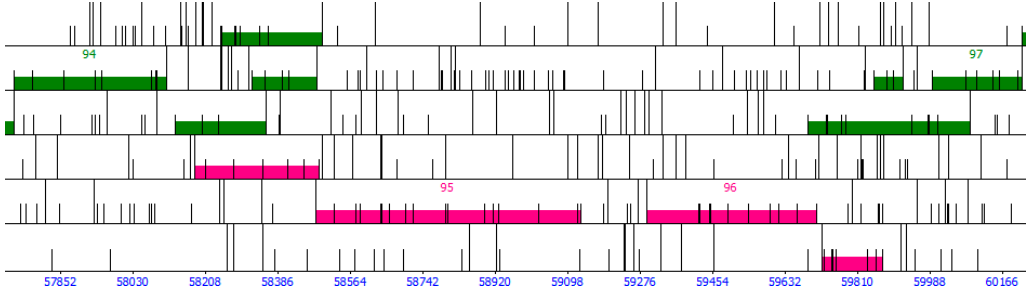
Figure 4. Examples of program-identified genes and user-identified putative genes in DNA Master. Each row corresponds to a reading frame; the forward (left to right) reading frames in the top three rows; the reverse (right to left) reading frames in the bottom three rows. Half height bars represent start codons; full height bars represent stop codons. Highlighted bars represent putative genes, with green for forward genes and magenta for reverse genes. Numbered genes indicate genes identified by Glimmer or GeneMark; genes without numbers indicate putative user-identified genes not identified by Glimmer and GeneMark. There are four putative user-identified genes located in the gap between gene 94 and gene 95 (three forward, one reverse) and three between gene 96 and 97 (two forward, one reverse).